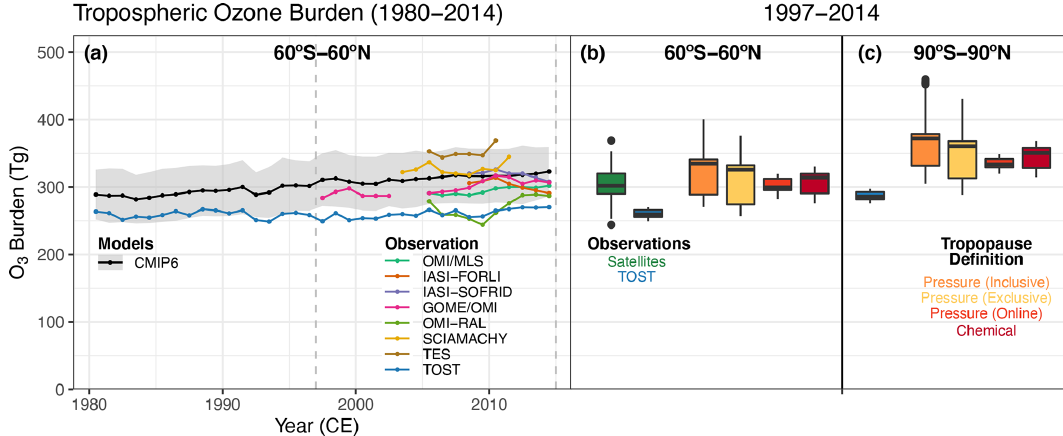
Figure 7. Evaluation of the present-day tropospheric-ozone burden. (a) Time series of tropospheric-ozone burden integrated from 60 ◦ S to 60 ◦ N for the period 1980 to 2014 (CE). The black line shows the CMIP6 ensemble mean using the pressure tropopause excluding the layer which contains the tropopause. The grey shading shows the mean ± 1 standard deviation of the ensemble inter-model variability for each year. The coloured lines show the annual mean tropospheric burdens reported by seven satellite products aggregated by Gaudel et al. (2018) and the ozonesonde trajectory product (TOST; Liu et al., 2013b, a). (b) Tropospheric-ozone burden distribution for 60 ◦ S to 60 ◦ N for the period 1997 to 2014CE, corresponding to the space between the two vertical dashed lines of panel (a) . Box-and-whisker plots show the distribution of the various satellite products (green) and TOST (blue), alongside the CMIP6 ensemble using four different tropopause definitions (see main text for details). (c) The same as panel (b) but showing the burden integrated from 90 ◦ S to 90 ◦ N in the TOST product and models. All units are inTg O 3 .